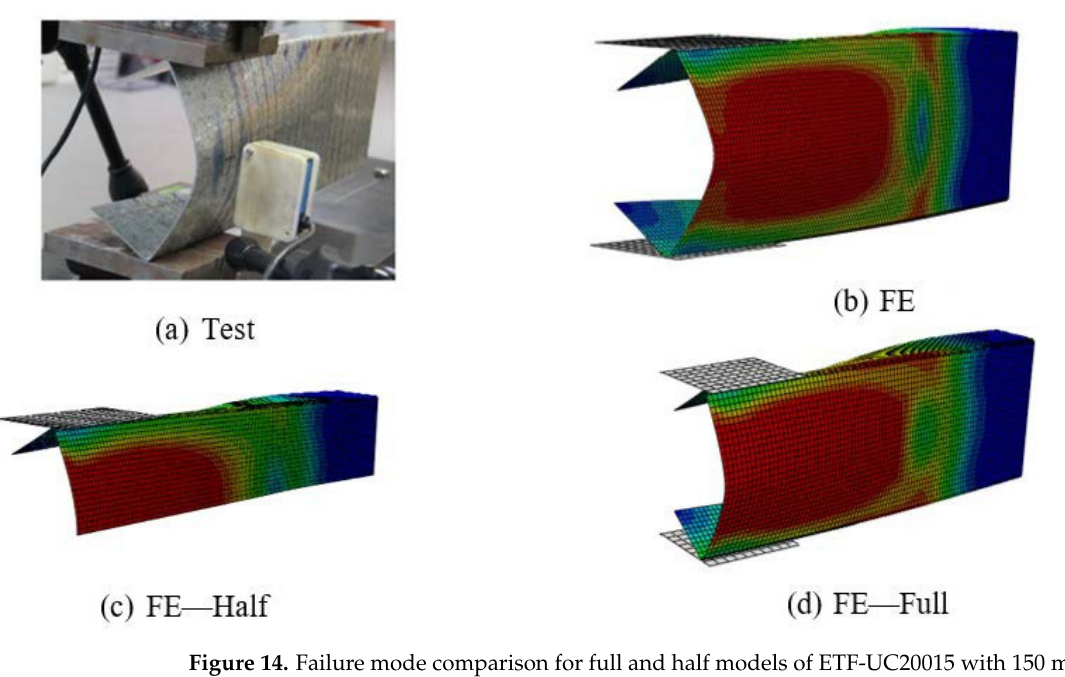
Figure 13. Failure mode comparison for full and half models of ETF-UC15015 with 100 mm bearing plate [21].